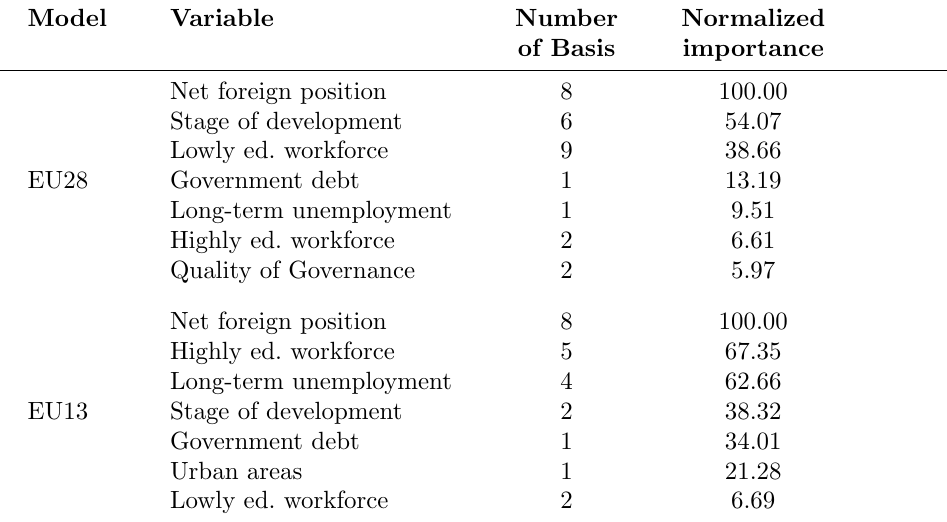
Table 5: Second-order MARS models: important variables for the EU28 and the EU13